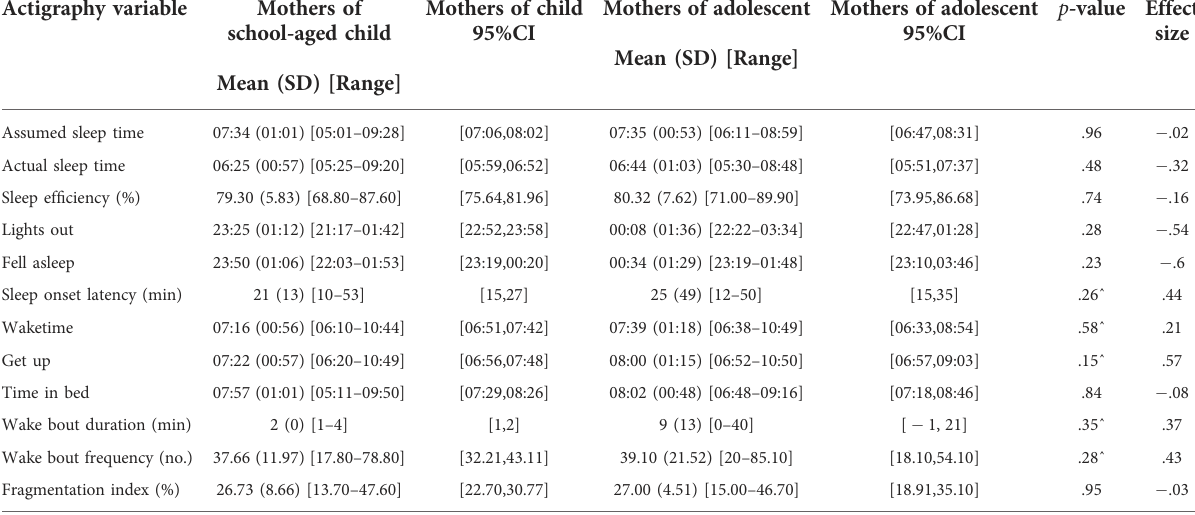
TABLE 5 Sleep pro fi les of mothers according to their child ’ s age group based on actigraphy and sleep diary data. Actigraphy variable Mothers of Mothers of child school-aged child